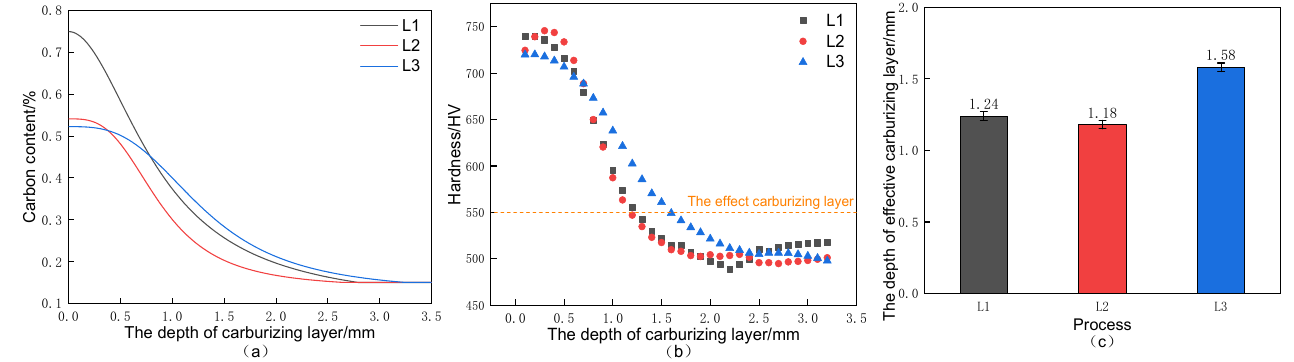
Figure 4. Comparison of different carburizing processes at 1000 °C: ( a ) carbon concentration profile; ( b ) microhardness profile; ( c ) the depth of effective carburizing layer.